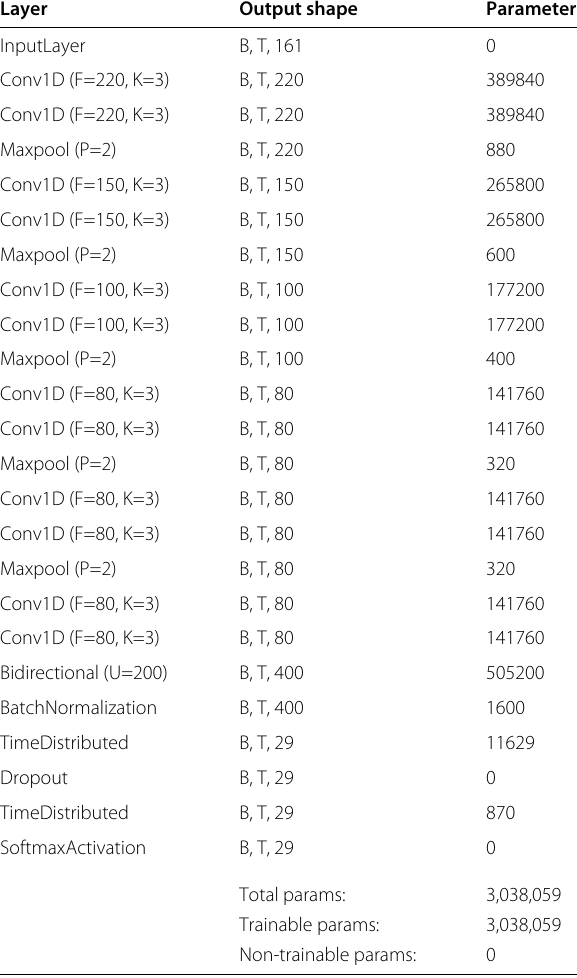
Table 2 Detailed architecture of the CNN-RNN model used as the loss network in style transfer